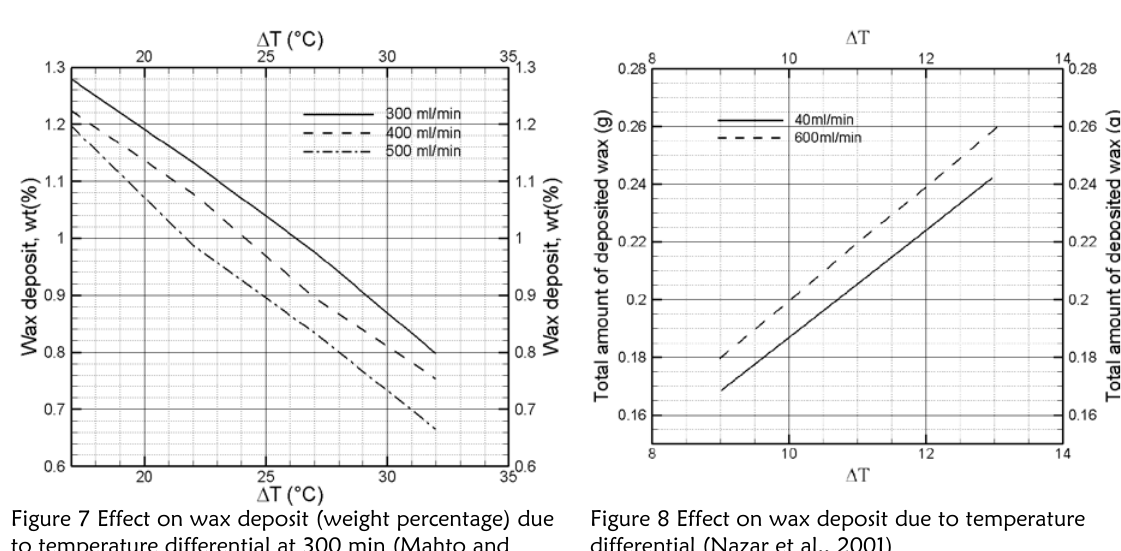
Figure 6 Effect on wax deposit (weight percentage) due to temperature differential at 180 min (Mahto and Kumar, 2013)